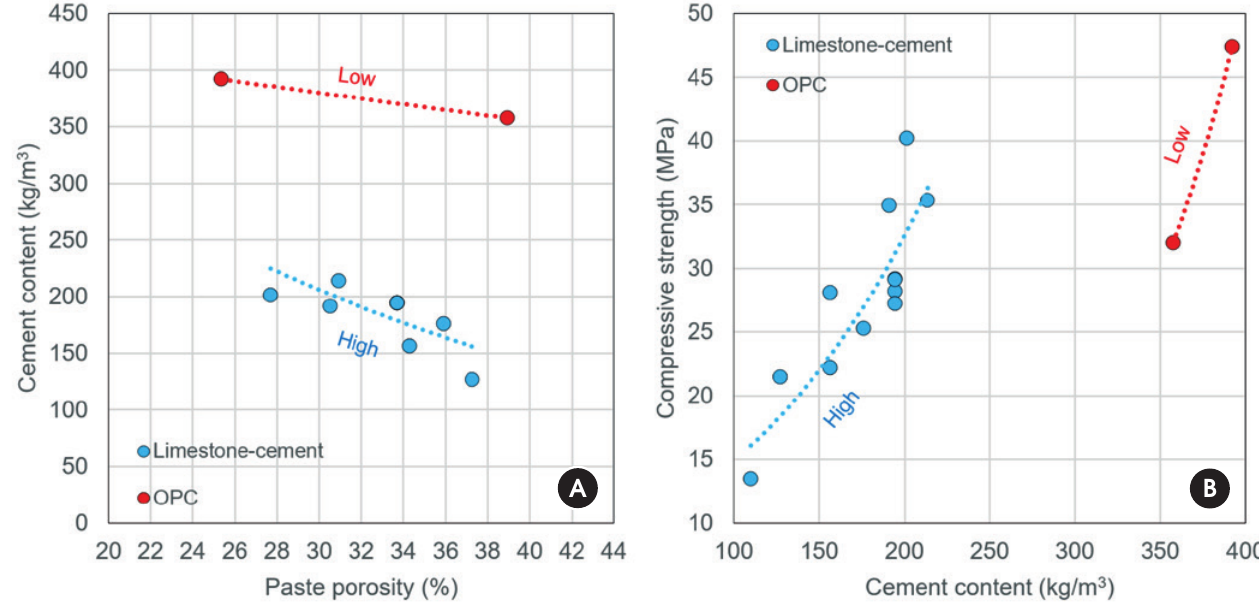
Correlation between: a) paste porosity and cement content; b) cement content and compressive strength of studied concretes. Red dots are low-packing concretes made from pure cement (paste); blue dots are high-packing concretes made from limestone-cement (paste)